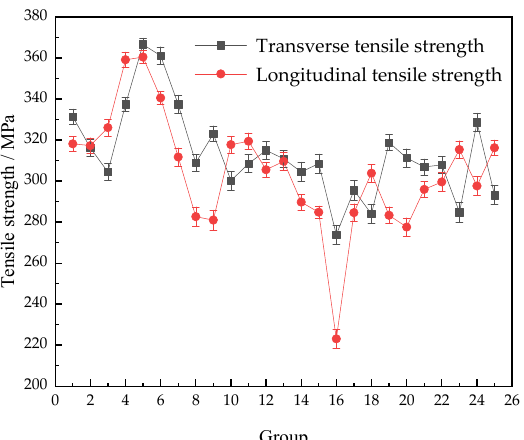
Figure 11. Tensile strength of Al-Mg alloyed additive under different process